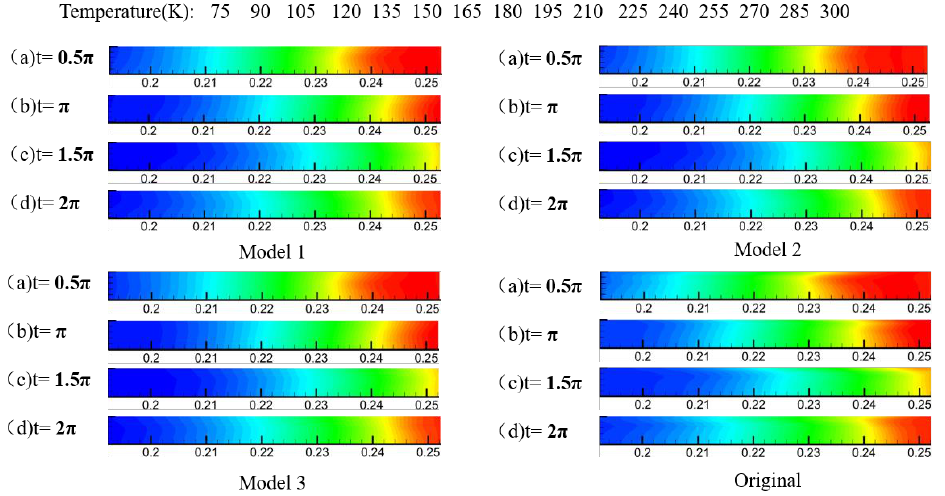
Figure 6. Pulse tube temperature cloud.